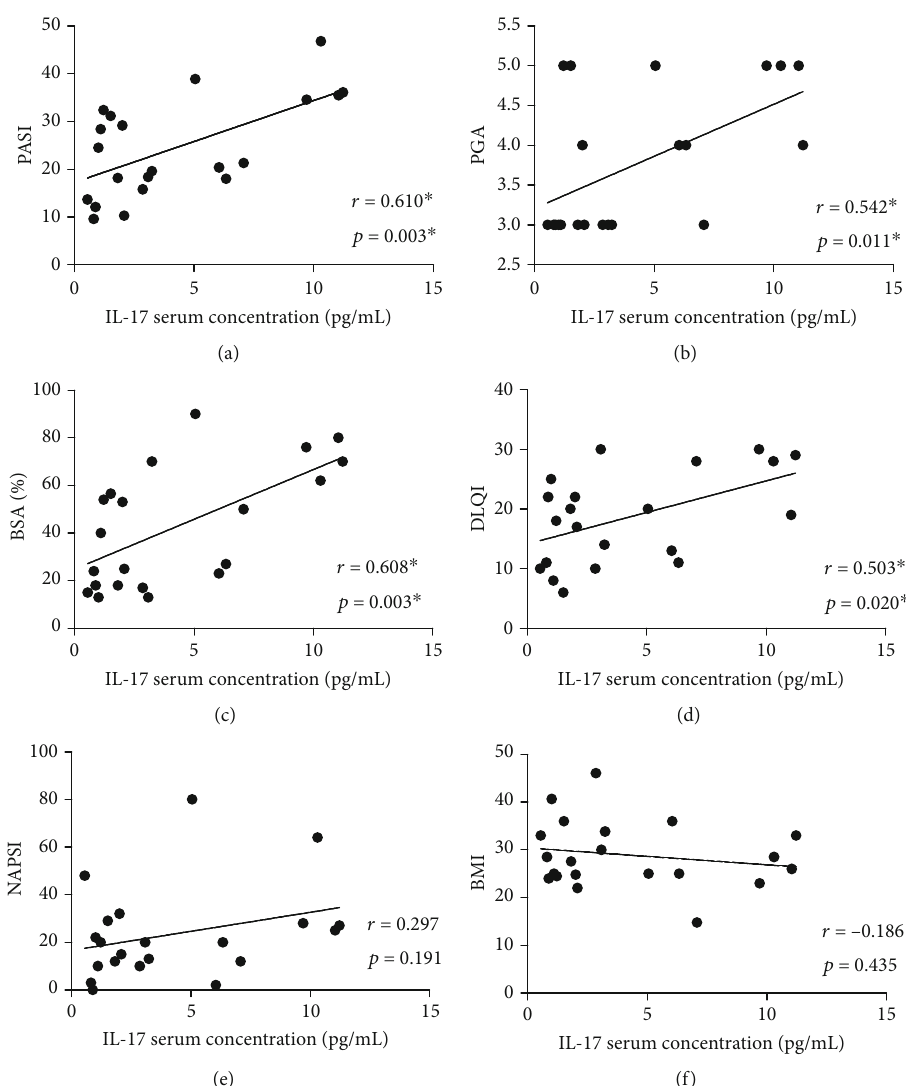
Figure 1: The correlation between IL-17 serum concentration and clinical features and disease severity in psoriatic patients; ∗ statistically signi fi cant